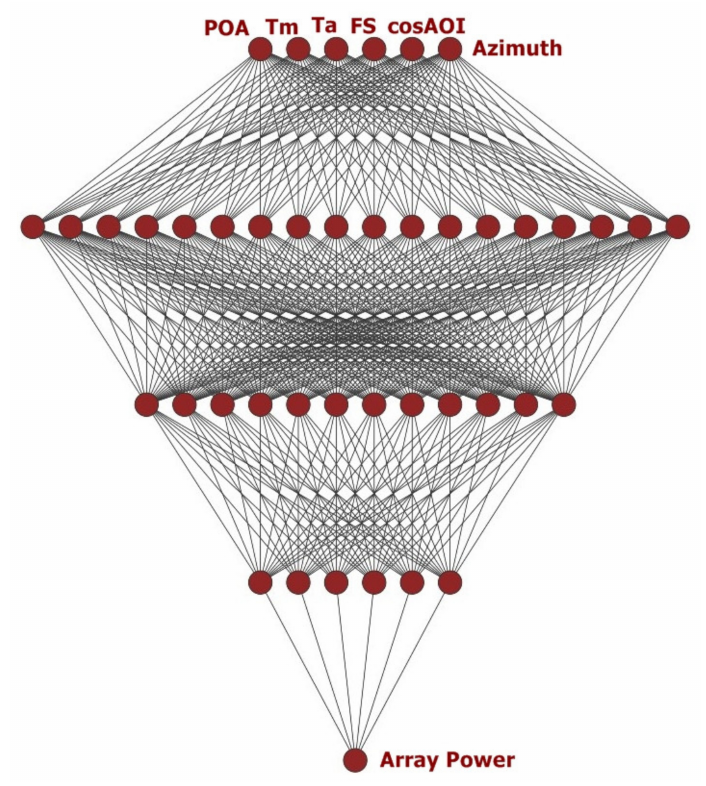
Figure 3. Artificial neural network scheme.